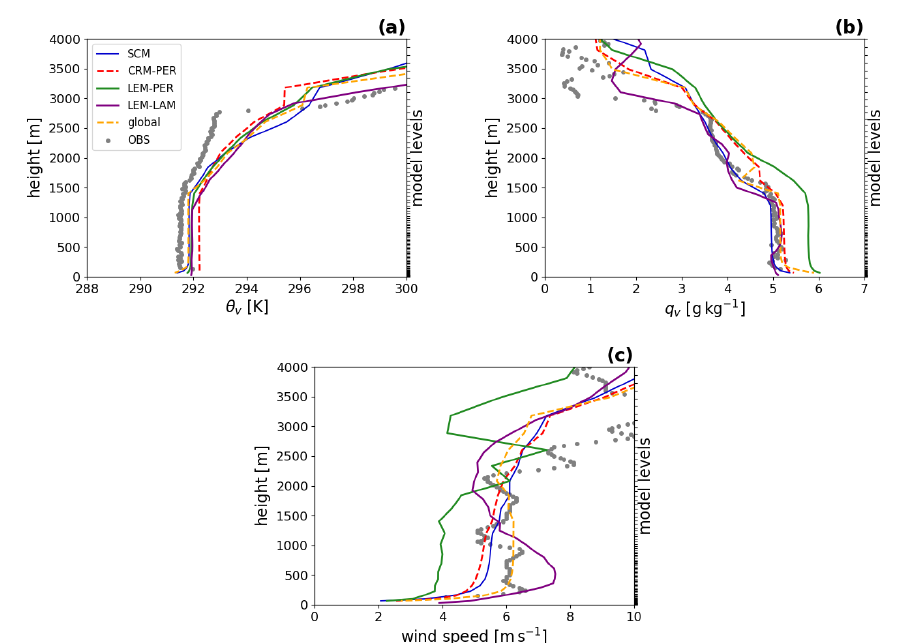
Figure 13. As in Figure 12, but comparison of profiles of ( a ) virtual potential temperature, ( b ) specific humidity, and ( c ) zonal wind speed. The simulation time at 18UTC is shown. The simulations are compared with radio sounding observations at meteorological observatory Lindenberg